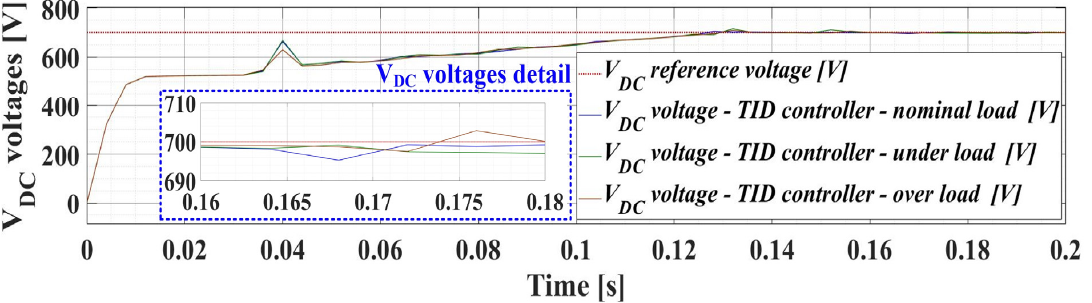
Figure 11. V DC voltages time evolution of the UPQC-APF control system based on TID controller in case of nonlinear load.